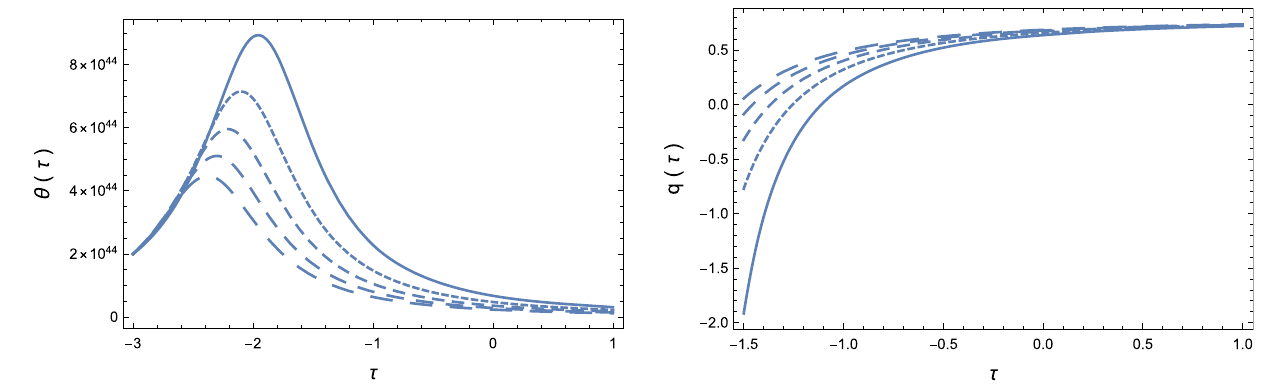
Fig. 7 Time evolution of the dimensionless temperature θ (left figure) curve), A 3 = 6 × 10 − 44 (short dashed curve), A 3 = 7 × 10 − 44 (dashed and of the deceleration parameter q (right figure)in a loop quantum curve), and A 3 = 8 × 10 − 44 (long dashed curve), respectively. The cosmological Universe filled with a deformed photon gas satisfying initial conditions used to numerically integrate Eqs. (71) and (72) are (cid:2) θ (τ ) = 2 × 10 44 , and with h the dispersion relation E = kc 1 − 2 β k 2 , for different values of the 0 0 obtained from Eq. parameter A 3 : A 3 = 4 × 10 − 44 (solid curve), A 3 = 5 × 10 − 44 (dotted